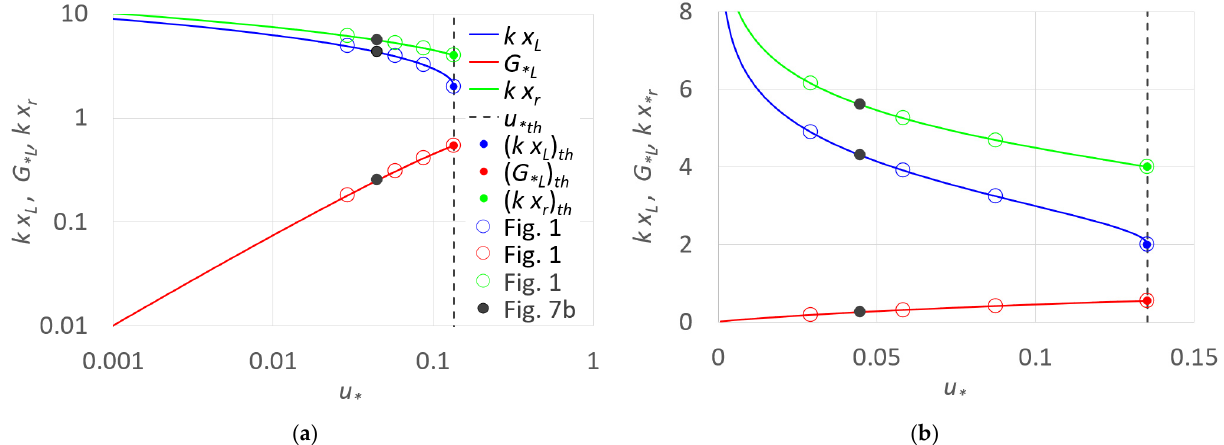
Figure 3. Relationship between the dimensionless parameters k x L (Equation (21)), G *L (Equation (24)), and k x r (Equation (26)) versus the normalized velocity recycle flow rate u * ( a ) in a log-log scale and ( b ) in a linear scale. Dots correspond to the applications performed later. For u * = u *th = 0.1353, the threshold values ( k x L ) th , ( G *L ) th , and ( k x r ) th (Table 1) are also indicated.